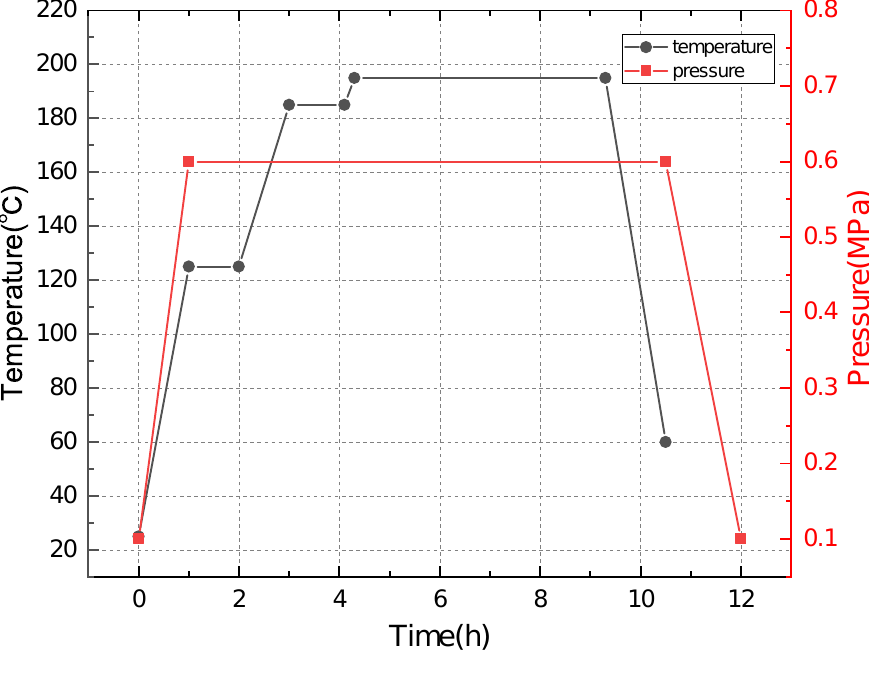
Figure 1. The curing process for the autoclave process.